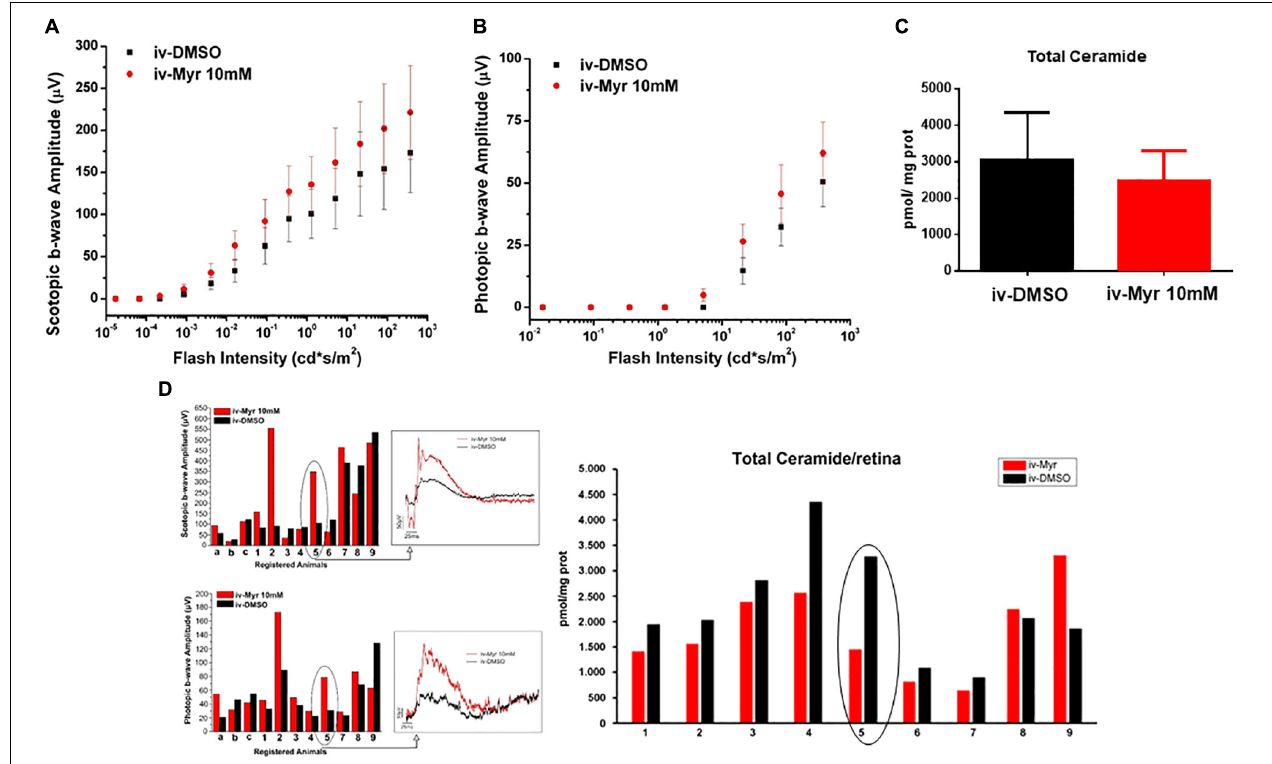
FIGURE 2 | Correlation between the decrease of ceramide content and functional recovery. (A,B) Sensitivity curve, respectively, of scotopic and photopic b-wave amplitude as a function of light flashes of increasing intensity. Although not significantly, the amplitude of the ERG response is increased in the eyes injected with Myriocin (red dots) compared to the eyes treated with the vehicle (black dots). Values represent mean ± SEM ( n = 12; 11). (C) Bar graph showing quantification of Ceramide content in the same retinal samples used for ERG analysis. The value represents mean ± SEM ( n = 9). (D) Correlation between retinal ceramide levels and functional activity. The bar graph on the left shows the scotopic and photopic b-wave amplitude recorded from Tvrm4 mice injected with 10 µ M Myriocin in the right eye (red bars) and with vehicle in the left eye (black bars); representative (i.e., average-size) traces recorded at the highest luminance used (377 cd*s/m 2 ) are shown in the squared boxes on the right. The bar charts in the right of the panel show HPLC-MS quantification of ceramide content in the same retinas used for the ERG analysis. A correlation between the functionality of retinal neurons and ceramide levels is noted, even in cases when Myriocin does not show a protective effect: for instance, animal 5 has a larger ERG response of the eye treated with Myriocin, which corresponds to reduced levels of ceramide; animal 9 shows a smaller amplitude of the ERG in the Myriocin-treated eye, which, however has a higher ceramide content, possibly as a result of improper eye injection procedures.